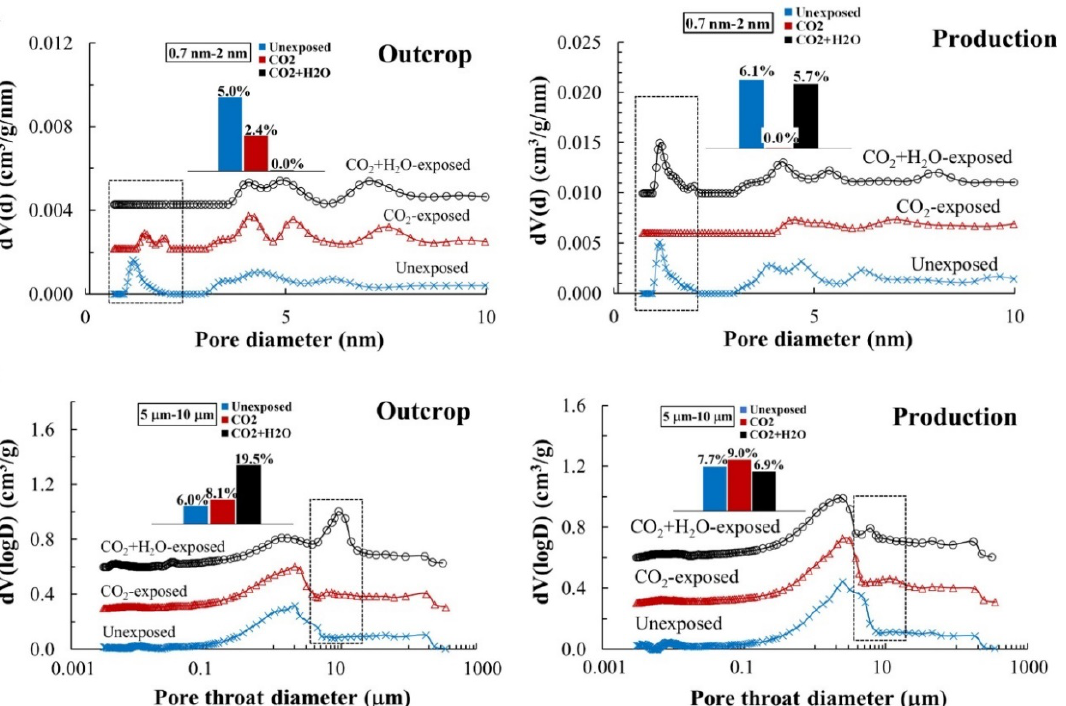
Figure 4. Pore size distribution analyses of the outcrop and production Utica shale samples: ( A ) 0.7 nm to 10 nm (from N 2 sorption isotherms) ( B ) 0.003 μm to 350 μm (from Hg porosimetry). Insets show corresponding pore volume distributions of the unexposed, CO 2 -exposed, and CO 2 + H 2 O − exposed samples for the 0.7 nm to 2 nm and 5 μm to 10 μm pore diameter ranges. Uncertainties are within ± 5% and traces are offset from each other for clarity. Reprinted from Goodman et al. [25]. Copyright (2020), with permission from Elsevier.